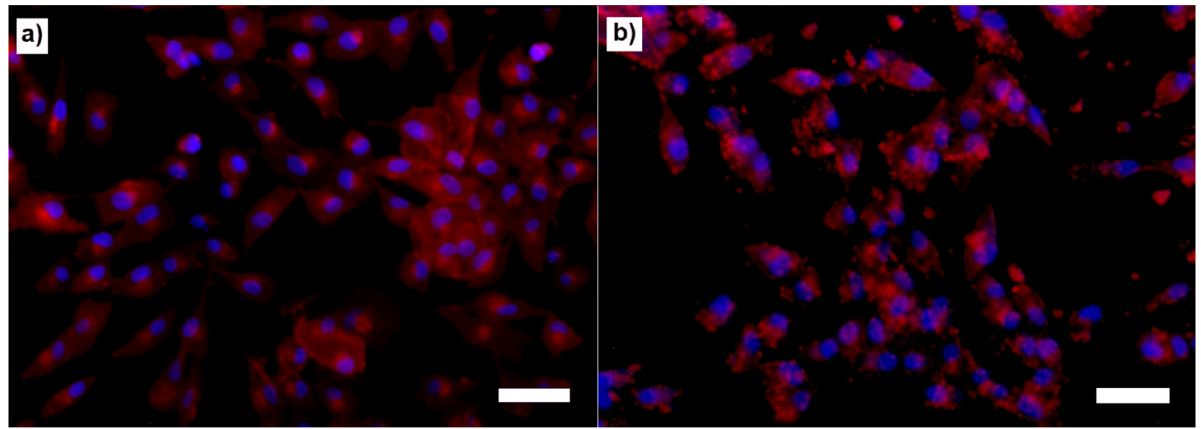
Figure 8. Fluorescence micrographs of MG-63 cells treated with ( a ) composite microspheres at 50:50 (PHBV/MBGN) ratio and a ( b ) similar amount of free MBGN after 24 h (bar size is 10 µm).